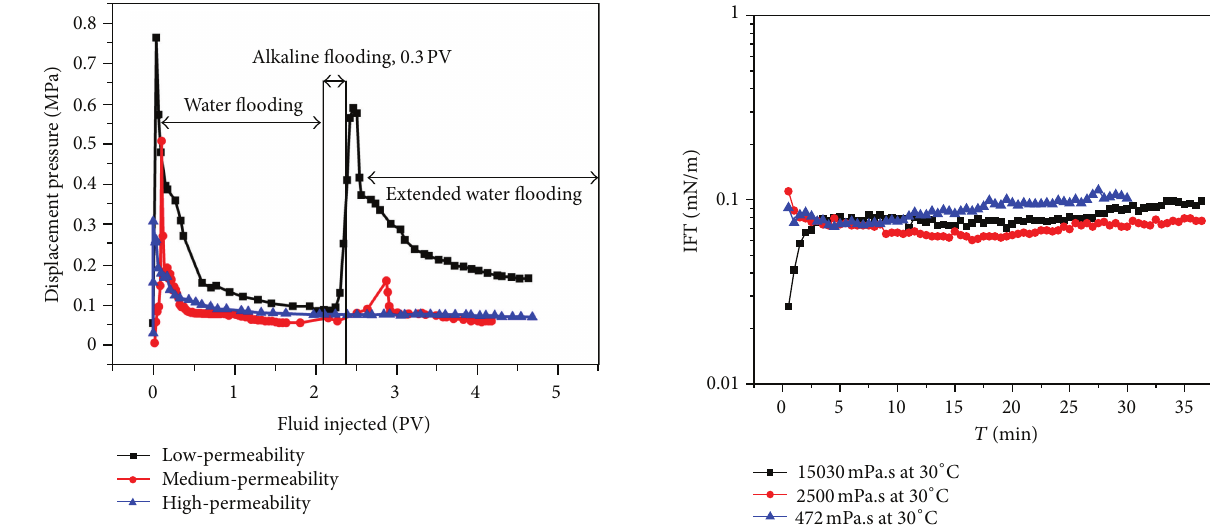
Figure 11: Dynamic IFT curves of Binnan heavy oil/0.5% NaOH + 0.5%